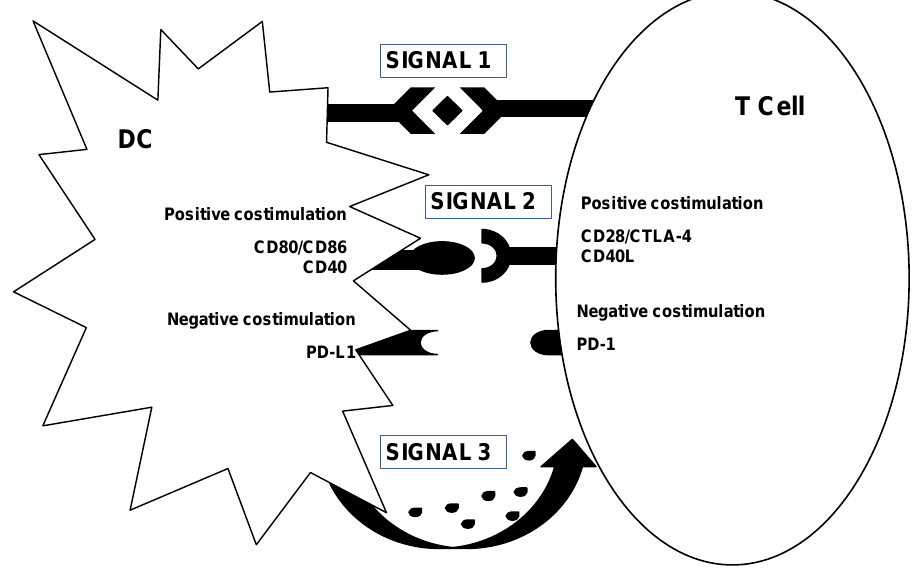
Figure 5. Three signal crosstalk between DCs and T cells. It is widely accepted that three signals have to be provided to T cells (cell on the right) by professional APCs such as DCs (cell on the left). The three T cell-stimulatory signals are indicated in the figure as boxes. The first signal (top interaction) is delivered upon binding of the peptide-MHC complex with the TCR on T cells. This interaction is not sufficient to activate T cells but rather drives them into anergy or tolerance. Integration of positive and negative co-stimulatory interactions delivers the second signal (central interaction). Some of the receptors and ligands involved in these interactions are indicated within each cell type. The release of cytokines or signal three (bottom interaction) completes the final activation of T cells by driving their differentiation into different T cell